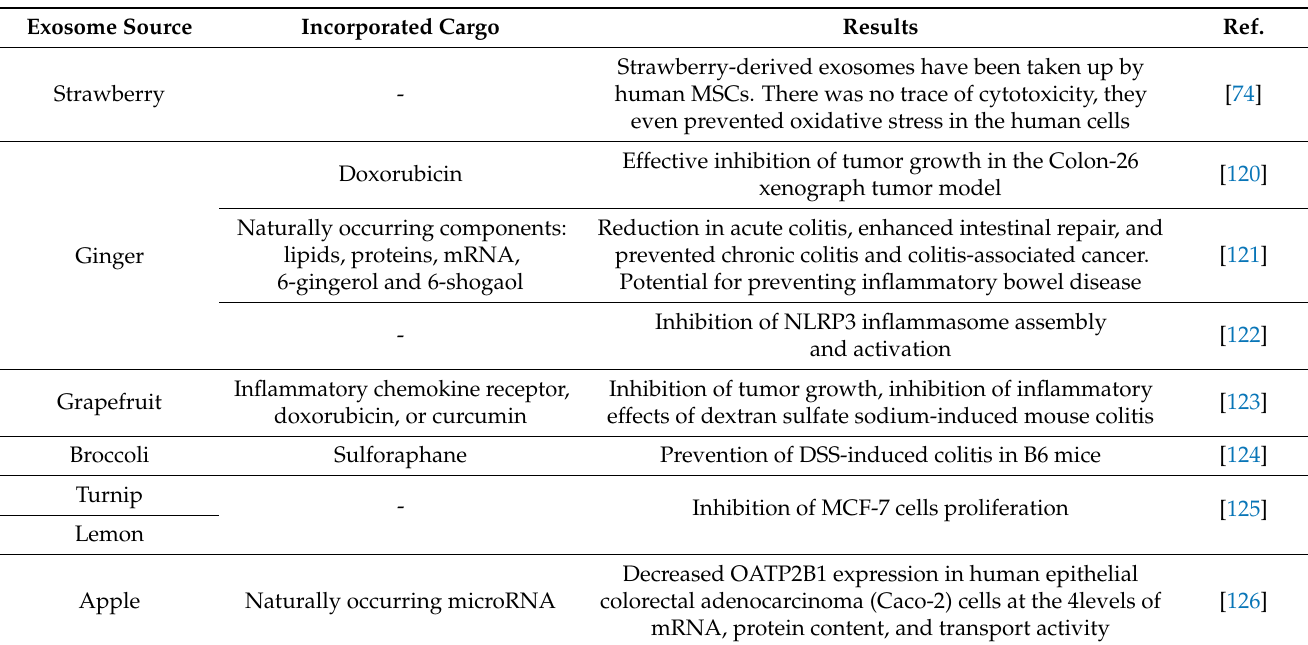
Table 3. Plant-based exosomes and their potential use as drug delivery